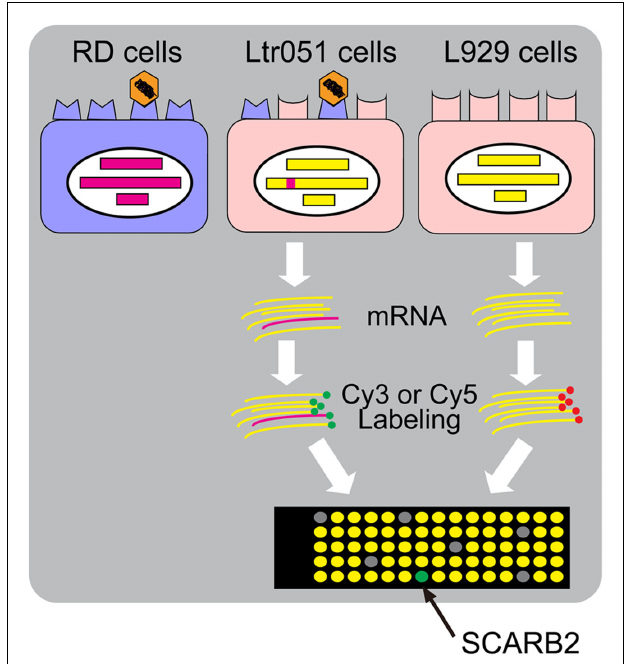
FIGURE 1 |The strategy to identify the human EV71 receptor, SCARB2. Mouse L929 cells became susceptible to EV71 when a human genomic DNA (red) was integrated into the genome (Ltr051 cells). RNA was prepared from Ltr051 cells and parental L929 cells and labeled with Cy3 or Cy5, respectively.The labeled RNAs were competitively hybridized to a microarray for human transcriptome analysis.The RNA species that were expressed in the Ltr051 cells but not in L929 cells were selected as candidates for the receptor mRNA. Each candidate was expressed in mouse L929 cells to examine the EV71 susceptibility of the transfected cells. SCARB2 expression alone was sufficient to achieve